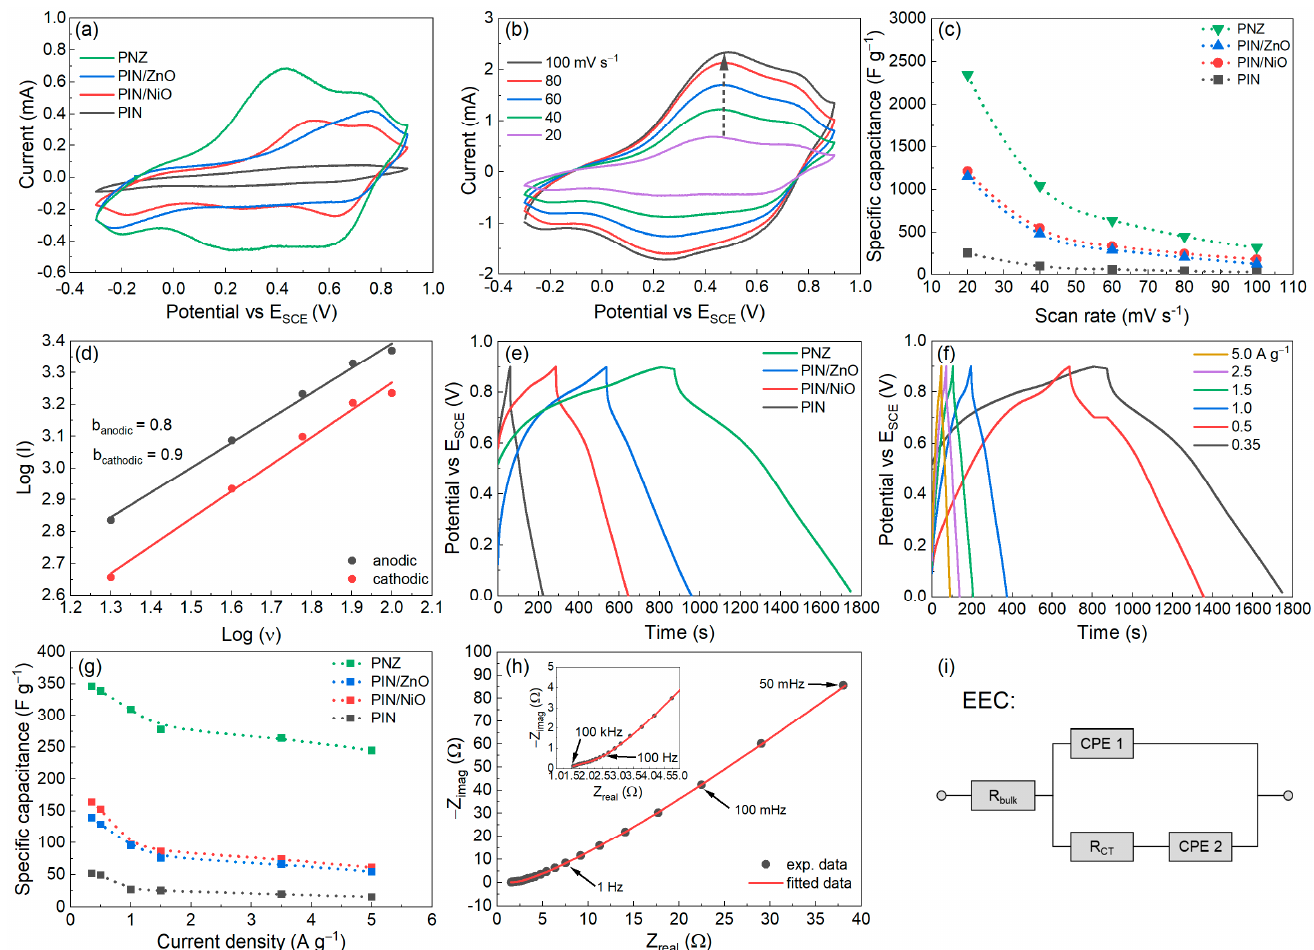
Figure 5. ( a ) CVs of PIn, PIn/NiO, PIn/ZnO, and PNZ-3 in three-electrode setup at 20 mV s − 1 in a potential range of 0 V to 0.9 V, ( b ) CVs of PNZ-3 at different scan rates, ( c ) calculated specific capacitances at different scan rates (20–100 mV s − 1 ) from the CVs of PNZ-3, ( d ) logarithmic correlation of the current response of PNZ-3 to the scan rate, ( e ) comparison of the GCD profiles of PIn, PIn/NiO, PIn/ZnO, and PNZ-3 at a current density of 1 A g − 1 in the potential range of 0 V to 0.9 V, ( f ) GCD curve of PNZ at different current densities (0.35 to 5.0 A g − 1 in a potential range of 0 V to 0.9 V), ( g ) specific capacitances of PIn, PIn/NiO, PIn/ZnO, and PNZ at different current densities (0.35 to 5.0 A g − 1 ), ( h ) EIS of PNZ at V DC = 200 mV in the frequency range of 100 kHz to 50 mHz, ( i ) electrical equivalent circuit (EEC) used for fitting the EIS spectra (the mass of polymer was 0.2 mg for all fabricated electrodes, and all CV, GCD, and EIS plots were recorded in 1.0 M H 2 SO 4 aqueous solution).